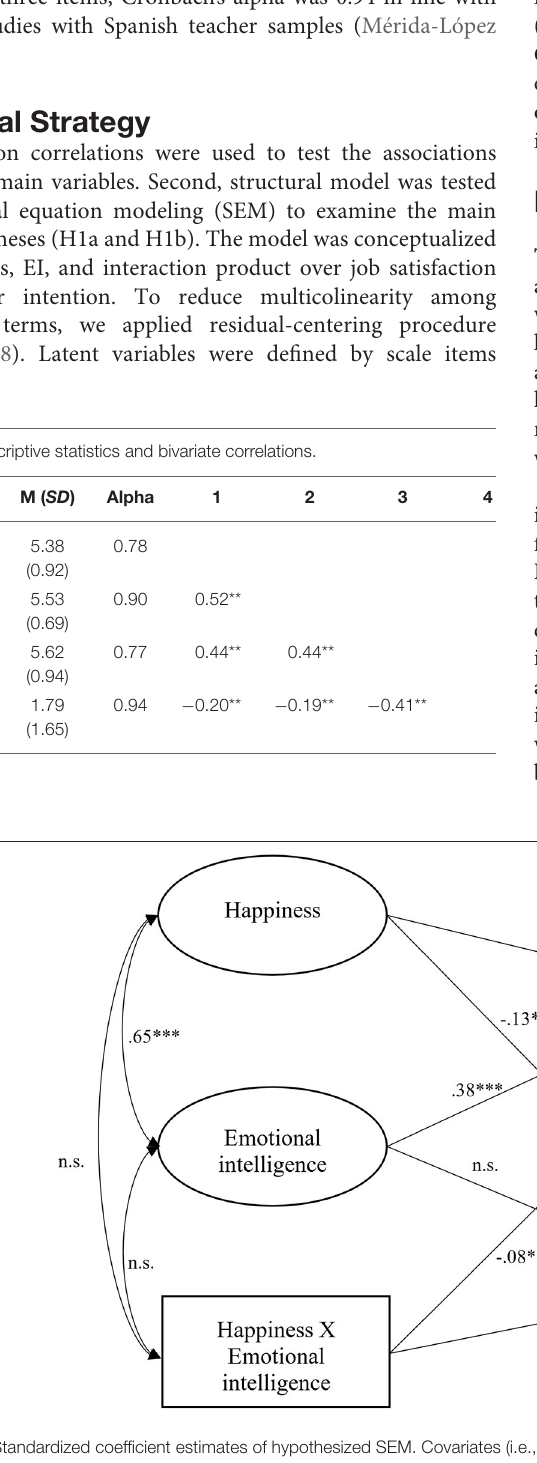
Frontiers in Psychology |